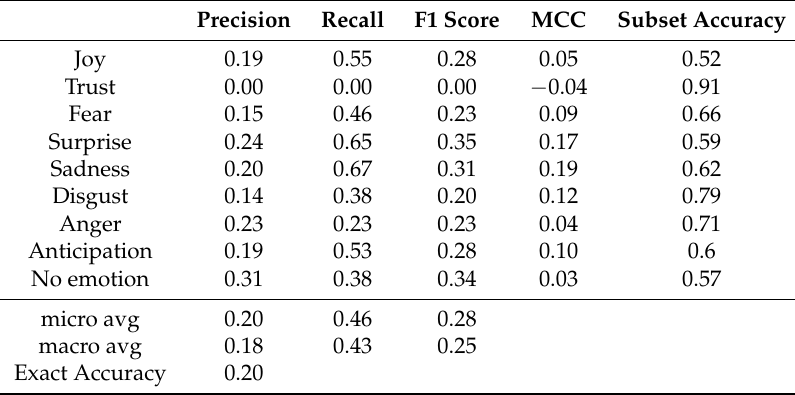
Table 11. ConceptNet Numberbatch—sentence embeddings.